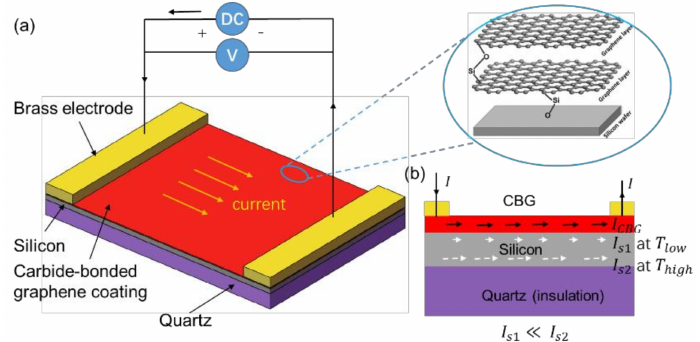
Figure 1. ( a ) Illustration of CBG Joule heating on silicon substrate, ( b ) current distribution between CBG coating and silicon substrate at low and high